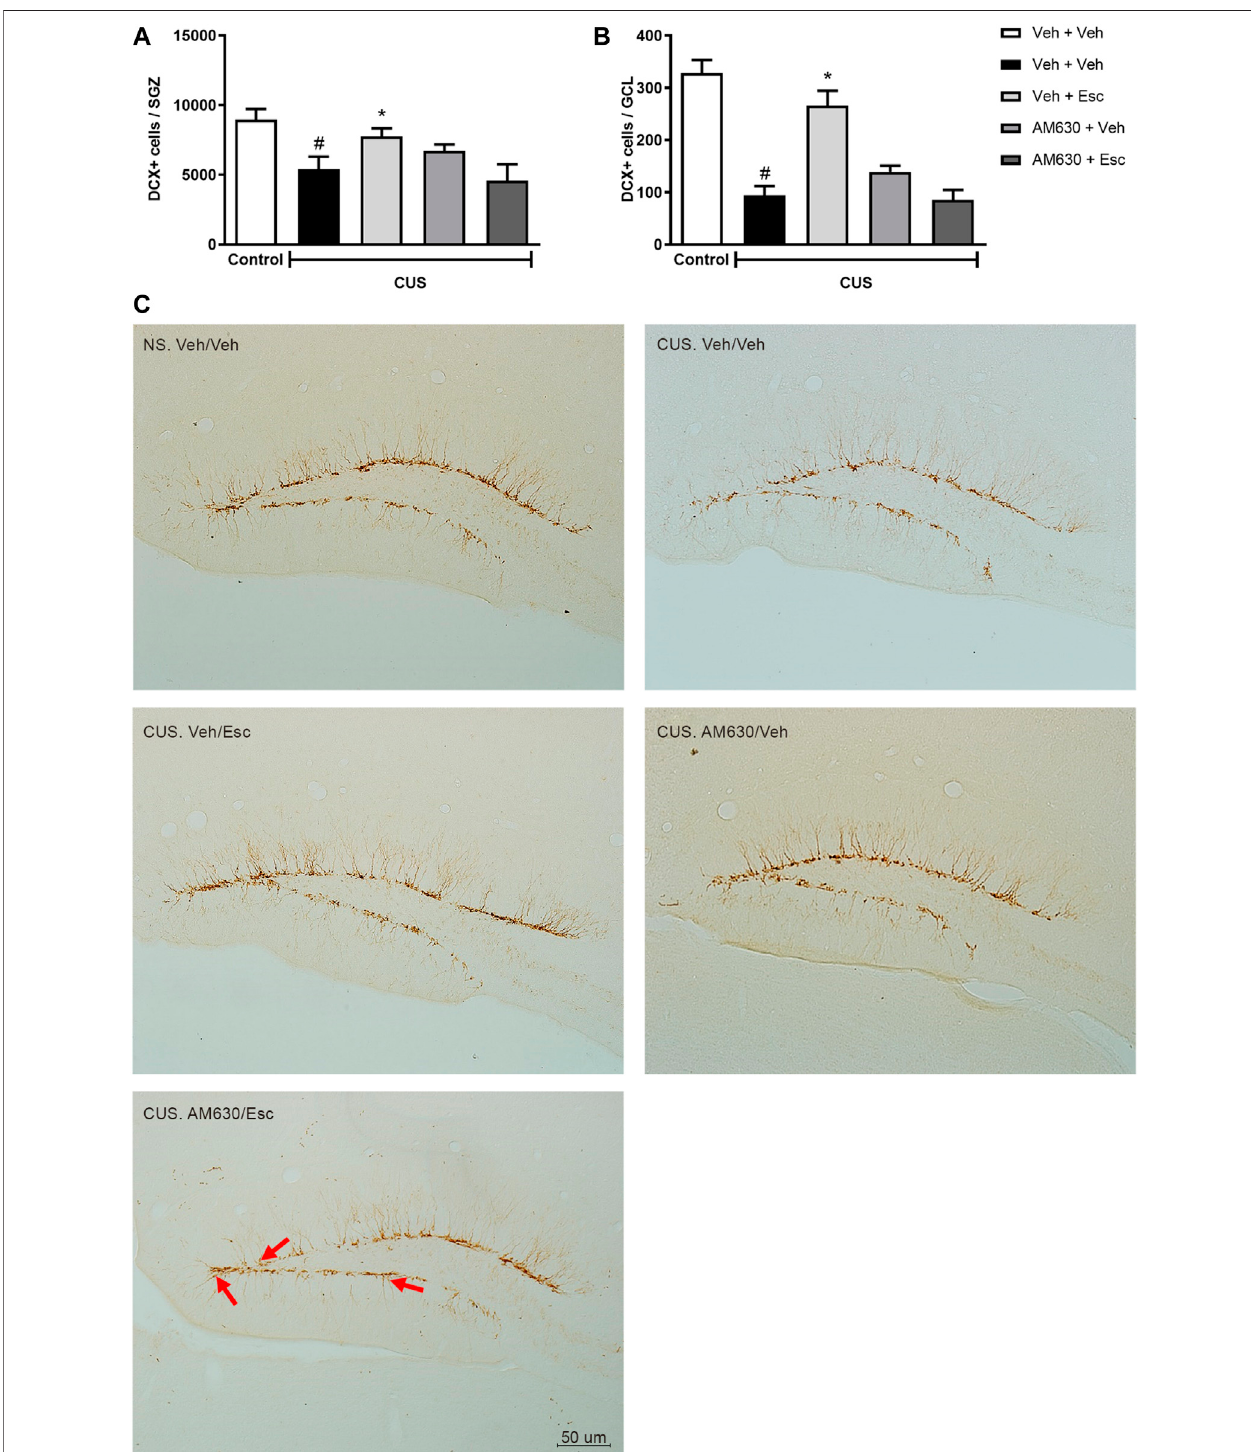
FIGURE 5 | DCX immunostaining in Dentate Gyrus of hippocampus. doublecortin positive cells (DCX+) expression in Subgranullar Zone of Dentate Gyrus (SZG) (A) ; Granular Cell Layer (CGL) (B) and representative photomicrograph of doublecortin positive cells (DCX+) located in the dentate gyrus of the hippocampus (C) . Red arrows indicate DCX + cells that have migrated from SGZ to the granular layer of the dentate gyrus of mice. Light Microscope (Olympus B202) at × 20 magni fi cation. Groupswere:NS/Veh+Veh( n (cid:1) 4);CUS/Veh+Veh( n (cid:1) 5);CUS/AM630/Veh( n (cid:1) 5);CUS/Veh+Esc( n (cid:1) 5);andCUS/AM630/Esc( n (cid:1) 5).ANOVA-TWOWAYwas employed and differences were considered statistically signi fi cant when p < 0.05 (# relative to NS/Veh + Veh and * relative to CUS/Veh + Veh).